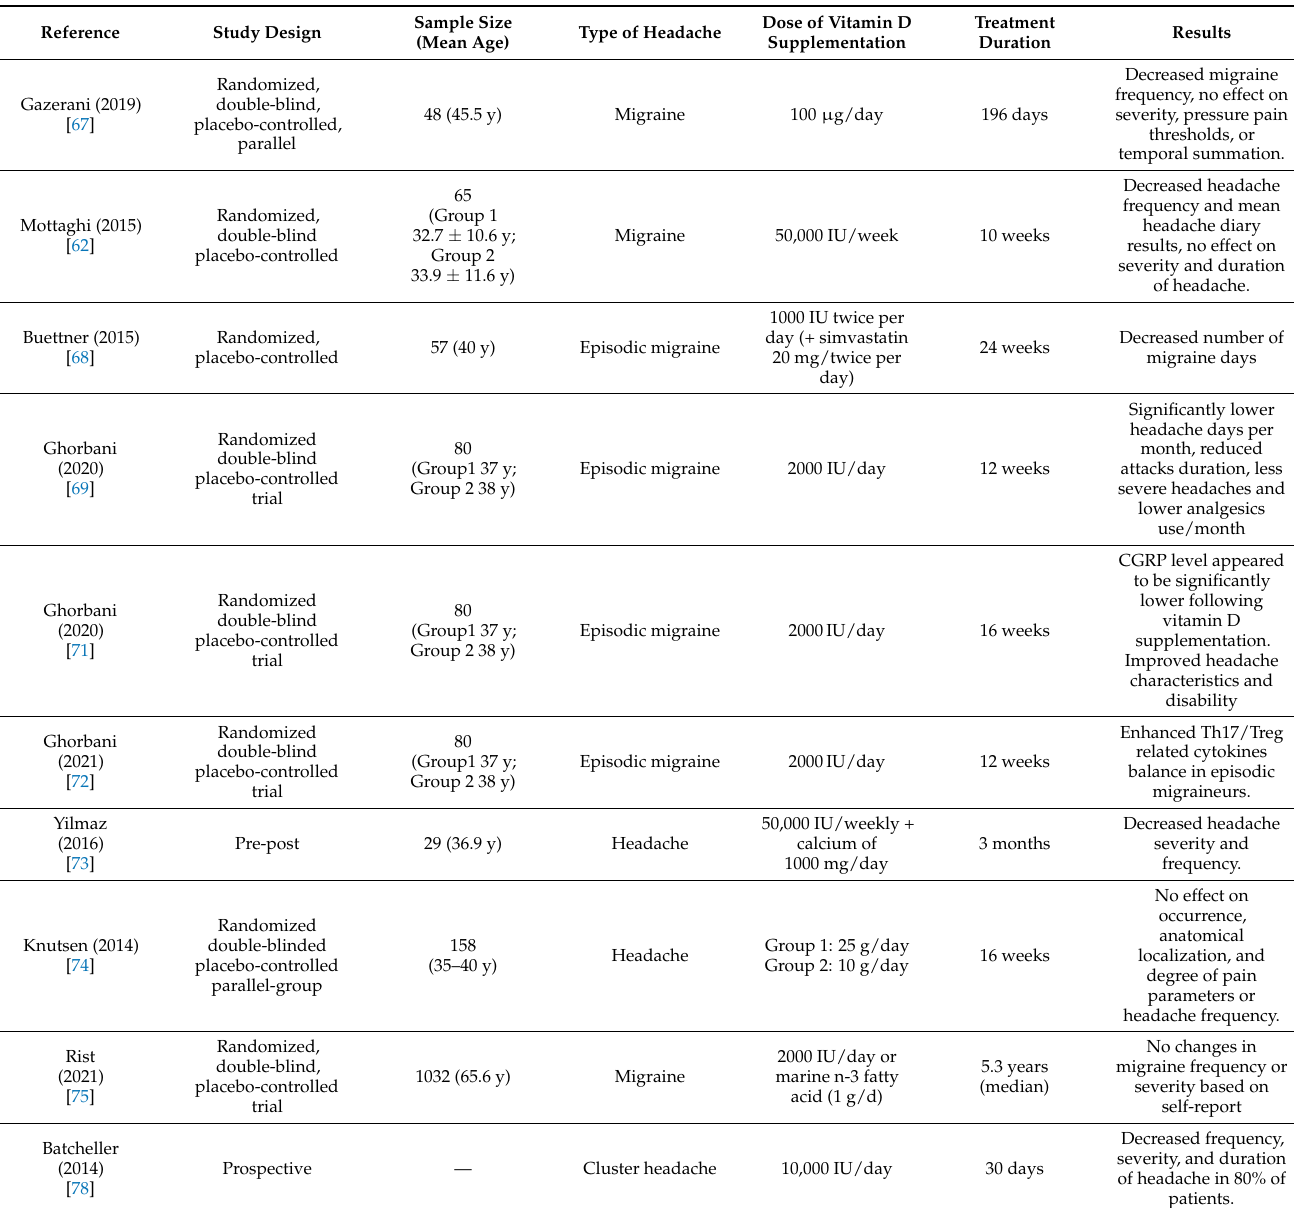
Table 1. Vitamin D Prophylaxis in Adult